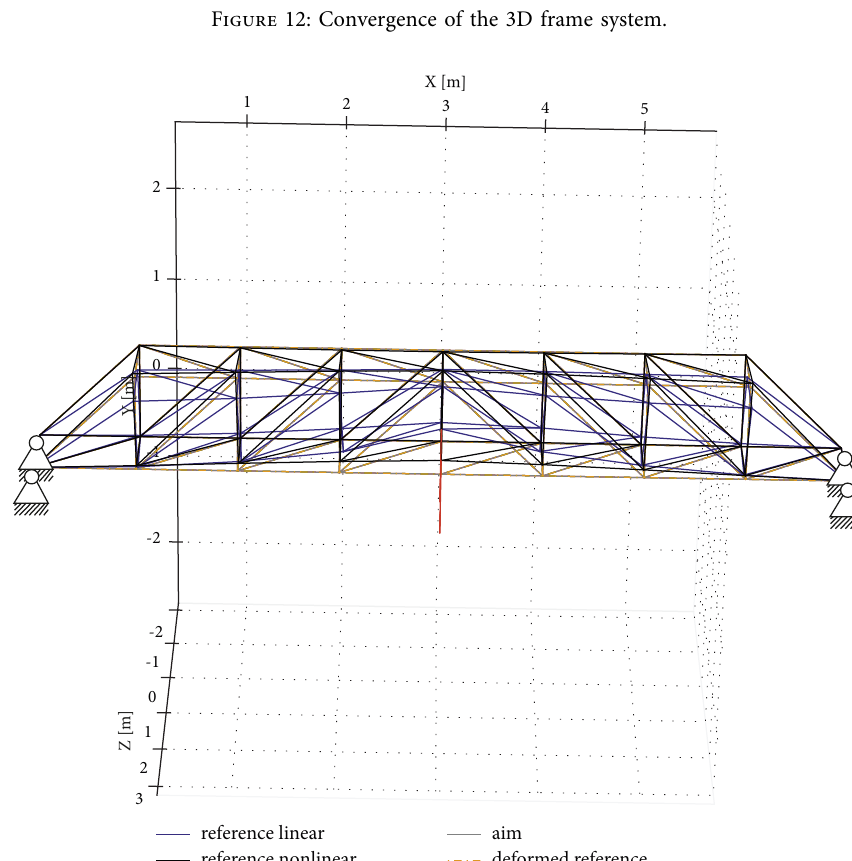
Figure 13: Unknown and known confguration of a 3D bridge structure. Te red arrow demonstrates the force vector [ 0 , − 800 , 0 ] N